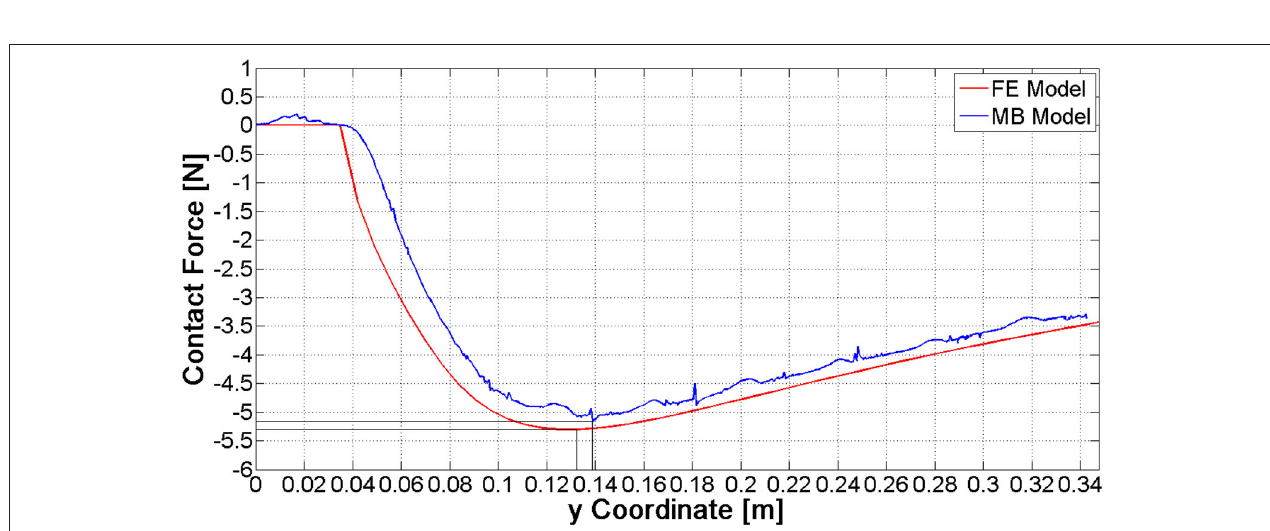
FIGURE 7 | Comparison of contact force curves between the FE and the MB model.